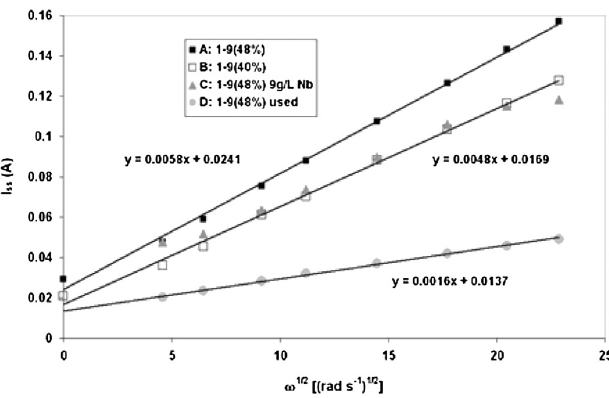
FIG. 3. Proportional relation between I ss and ! 1 = 2 at 5 V.